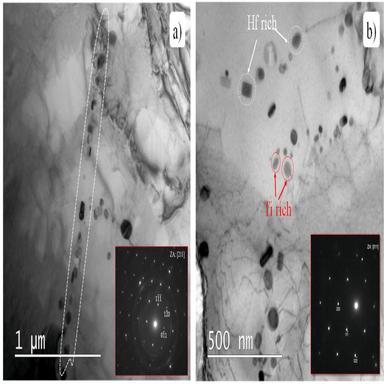
TEM micrographs of a) PPB network along with the SADP of HfO2 precipitates (inset) and b) Hf rich and Ti rich carbides and SADP of TiC (inset).